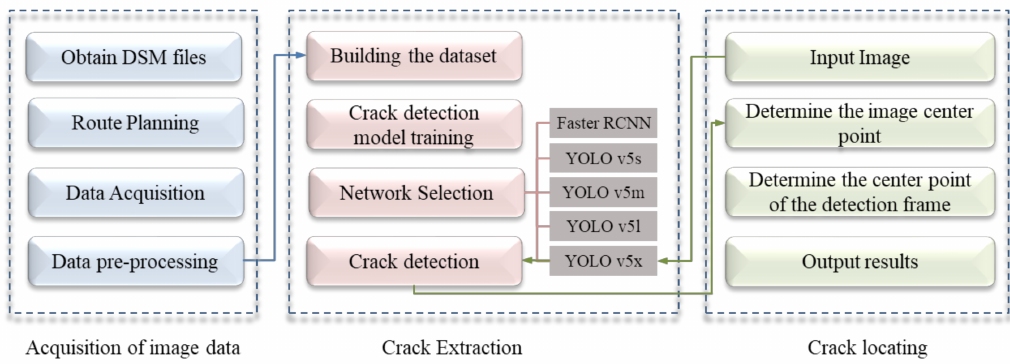
Figure 1. Flow chart of the method of crack detection and